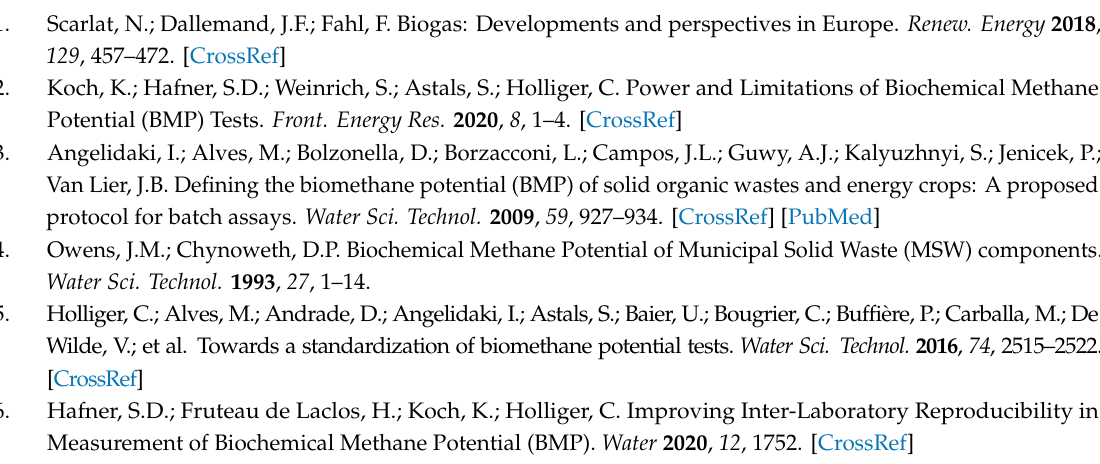
Figure S1: Model calibration example for specific methane production of manometric method (mixing mode 1) along test duration. Lines illustrate the BMP first order model calibrated on real measures. Figure S2: Model calibration example for specific methane production of manometric method (mixing mode 2) along test duration. Lines illustrate the BMP first order model calibrated on real measures. Figure S3: Model calibration example for specific methane production of gravimetric method (mixing mode 1) along test duration. Lines illustrate the BMP first order model calibrated on real measures. Figure S4: Model calibration example for specific methane production of gravimetric method (mixing mode 2) along test duration. Lines illustrate the BMP first order model calibrated on real measures. Figure S5: Model calibration for specific methane production of AMPTS II. Lines illustrate the BMP first order model calibrated on real measures. Figure S6: Model comparison. (a) BMP values and B0 for manometric and gravimetric method, mixing mode 1 and mixing mode 2; (b) k values for manometric and gravimetric method, mixing mode 1 and mixing mode 2; (c) λ values for manometric and gravimetric method, mixing mode 1 and mixing mode